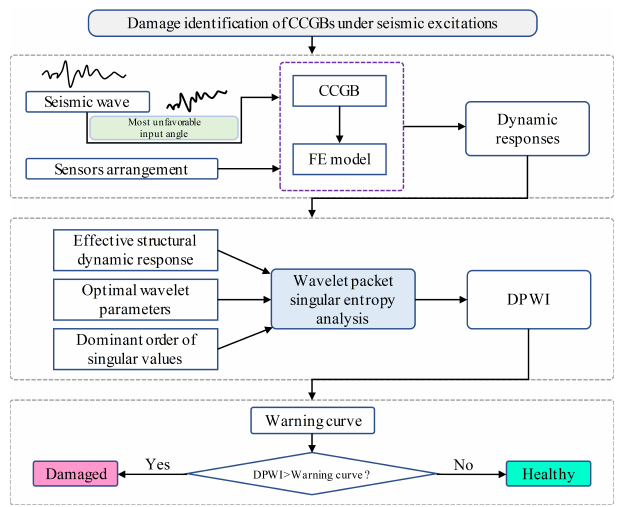
Figure 1. Roadmap of WPSE-based damage identification method for CCGBs.